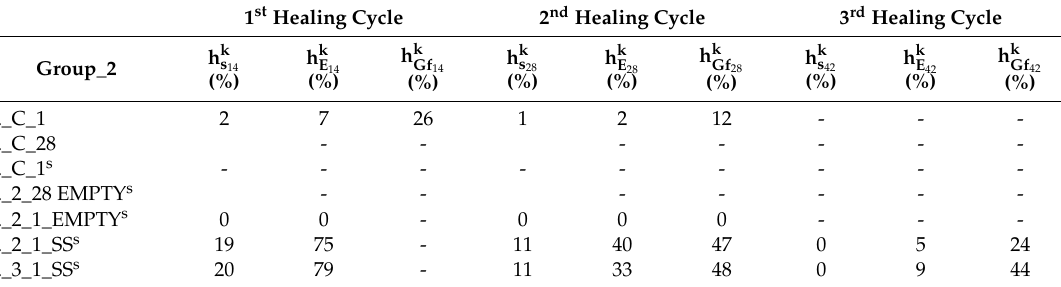
Table 5. Group 2: Healing indices for three damage-healing